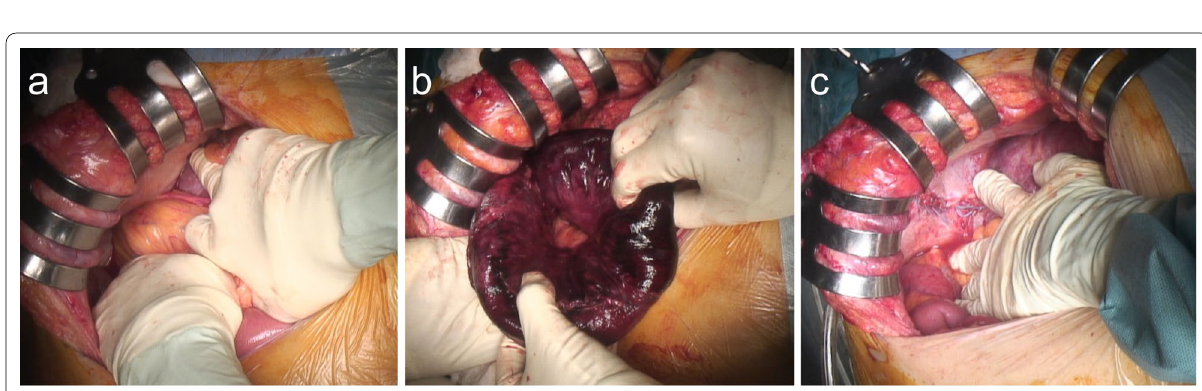
Fig. 4 Intraoperative findings. a The small intestine herniated into the right diaphragm. b The small intestine was necrotic (> 30 cm). c After repairing the hole in the